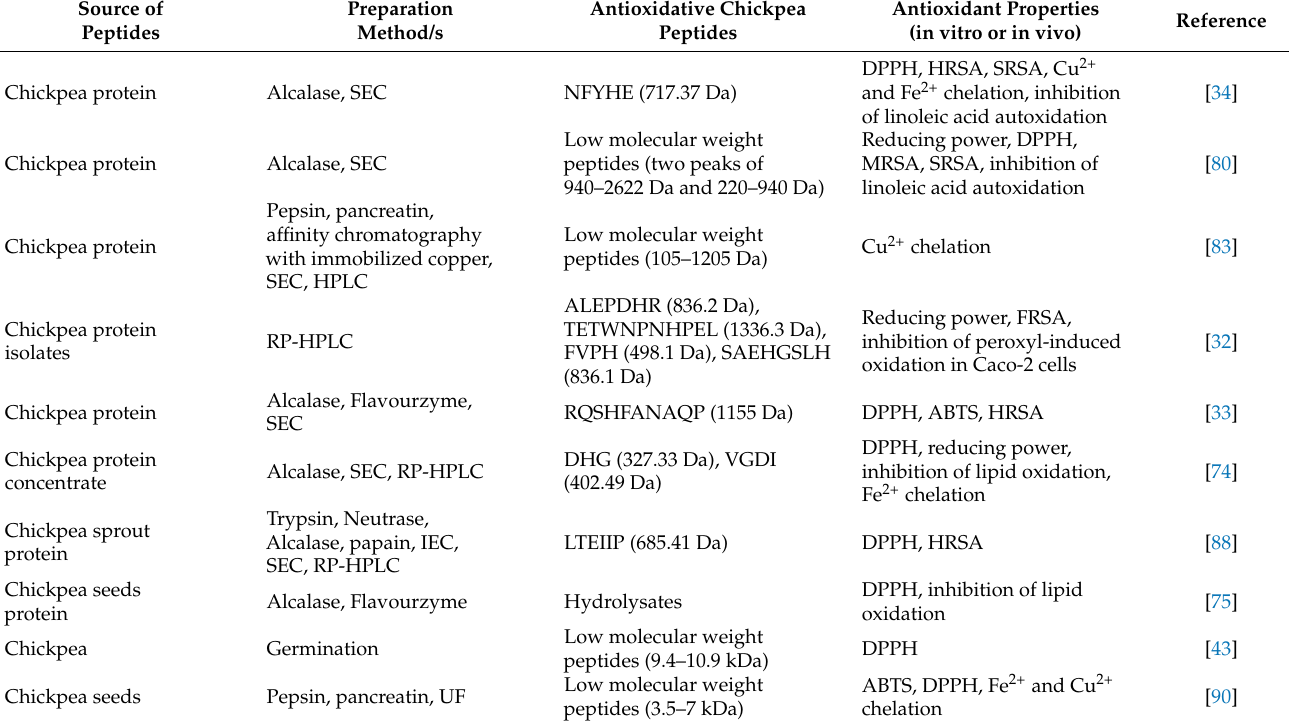
Table 2. Antioxidant properties of chickpea-derived hydrolysates and